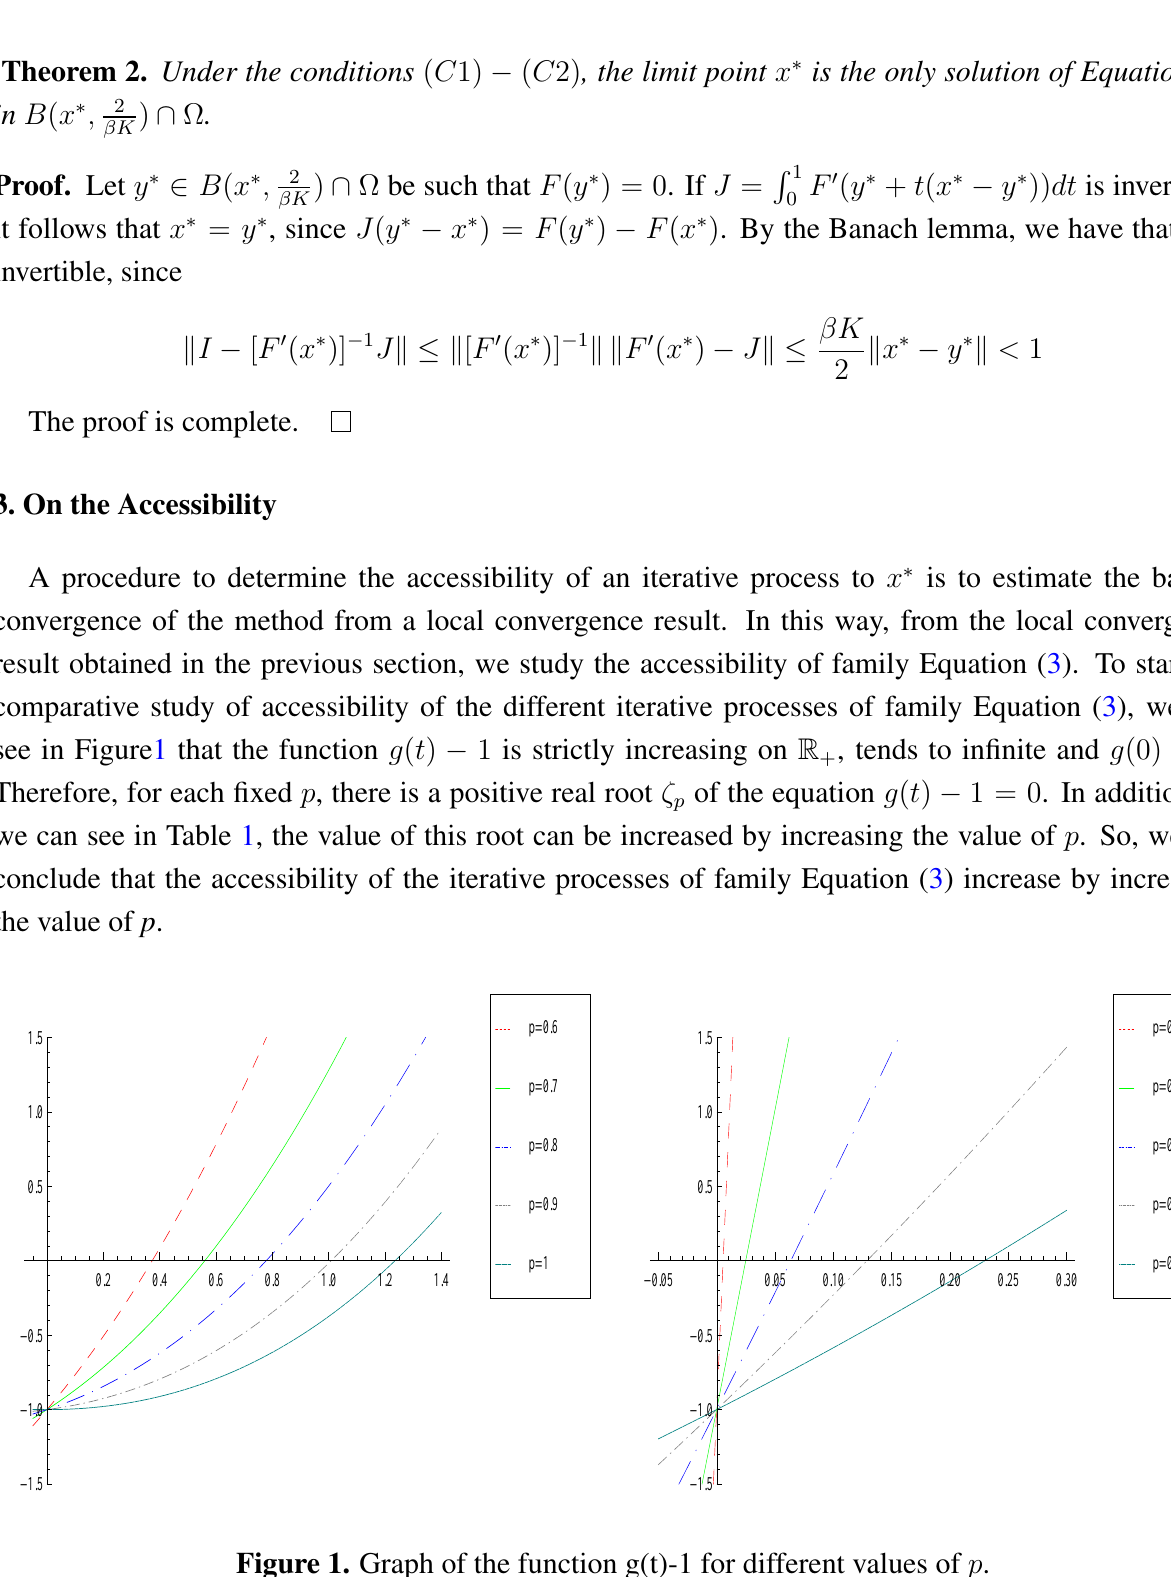
Figure 1. Graph of the function g(t)-1 for different values of p